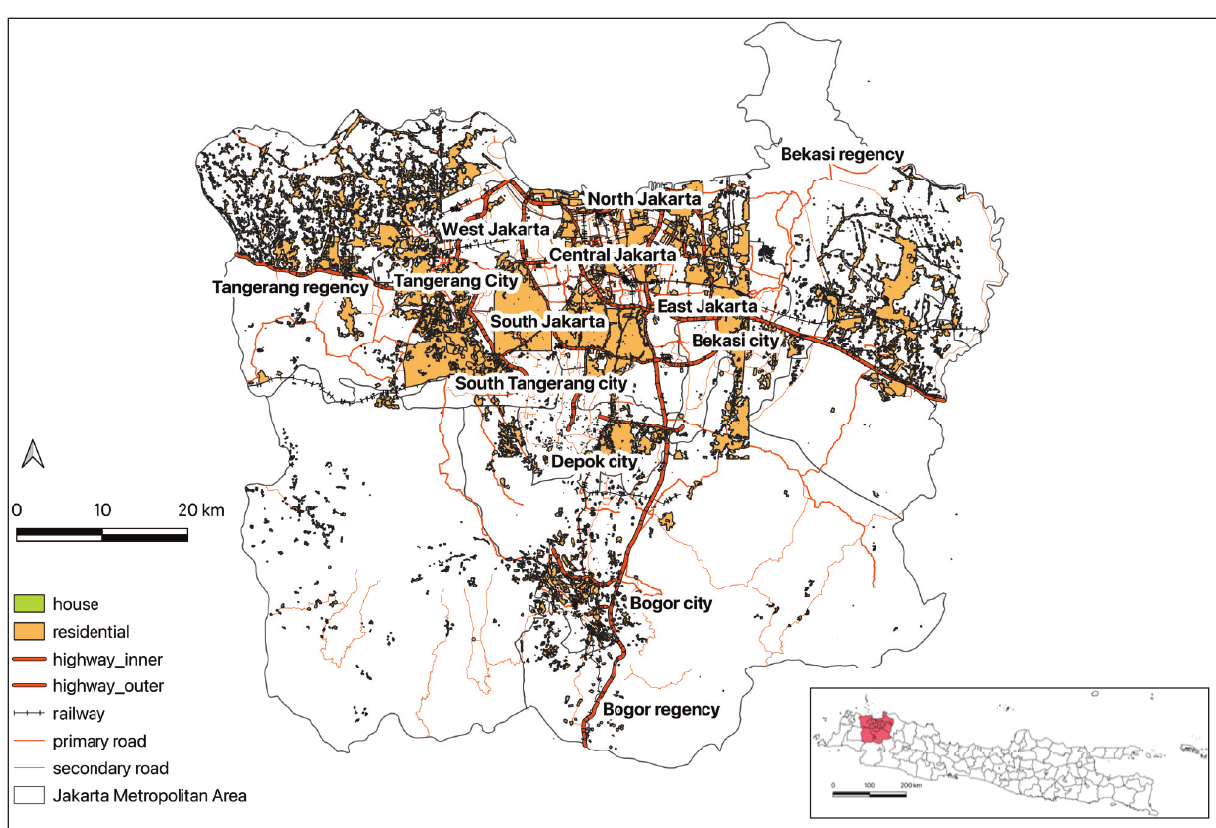
Figure 1. Distribution of infrastructure connectivity and residential areas in